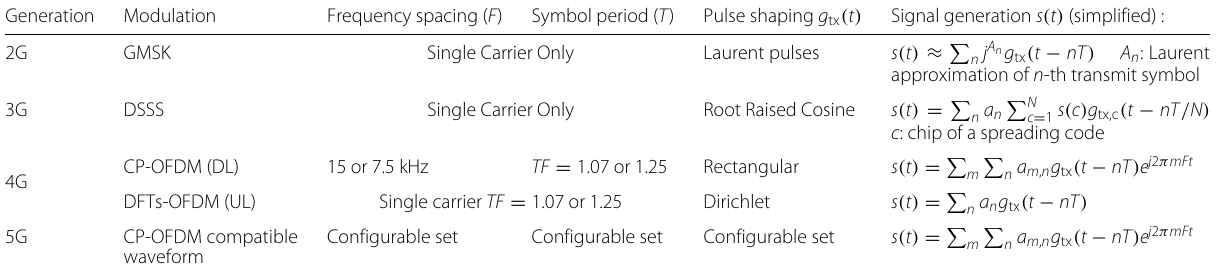
Table 1 Summary of transmit signal model in the standardized digital mobile systems